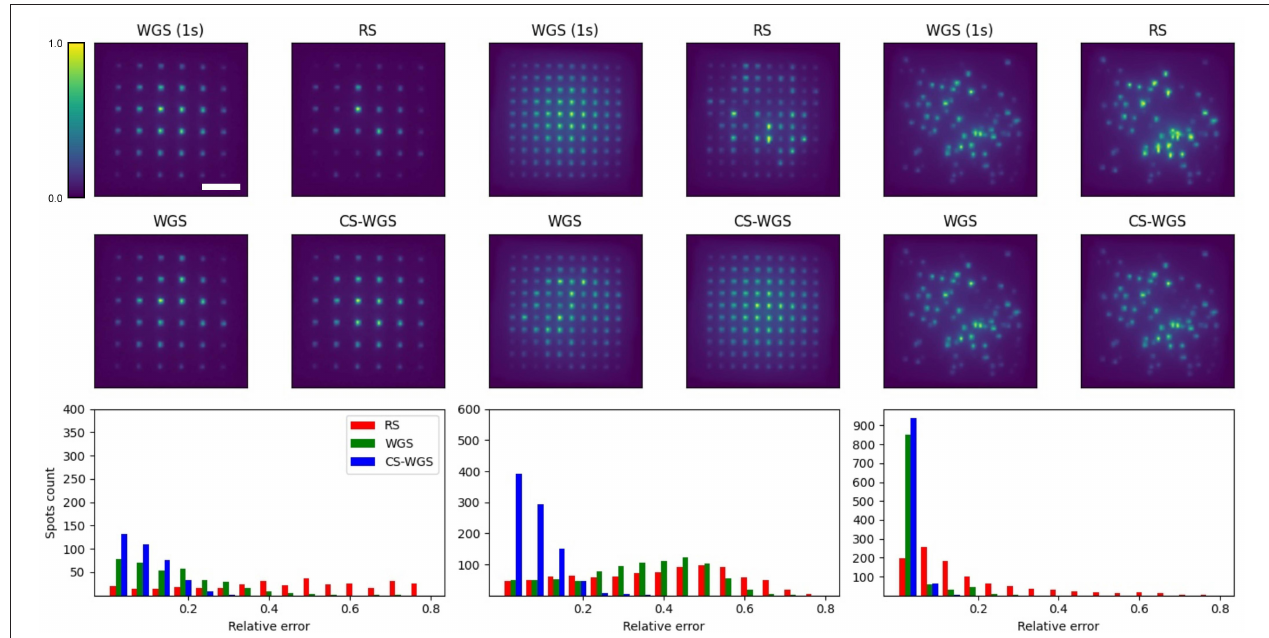
FIGURE 4 | Experimental results, each columns shows representative images for each scenario. Scale bar is 100 µ m . Scale bar and intensity colorbar are equivalent for all images. It should be noticed how, qualitatively, CS-WGS patterns are practically indistinguishable from full convergence WGS patterns. Significant artifacts can be observed in the grid patterns for both RS and WGS. Significant artifacts are visible for RS in the random spots distribution, while WGS qualitatively seems to perform well. On the bottom row, histograms of the detected spots intensity accuracy over 10 images are shown. It should be observed how CS-WGS does actually outperform significantly WGS, with no spots over 0.25 relative error, while WGS presents outliers up to 0.4.